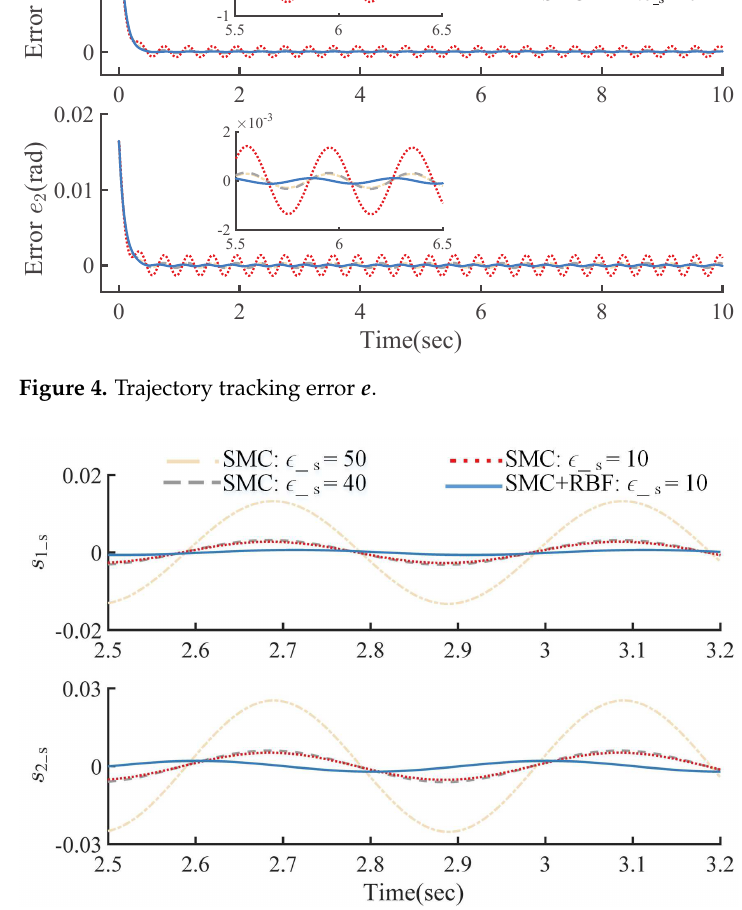
Figure 5. Time history of the slow sliding surface s _s